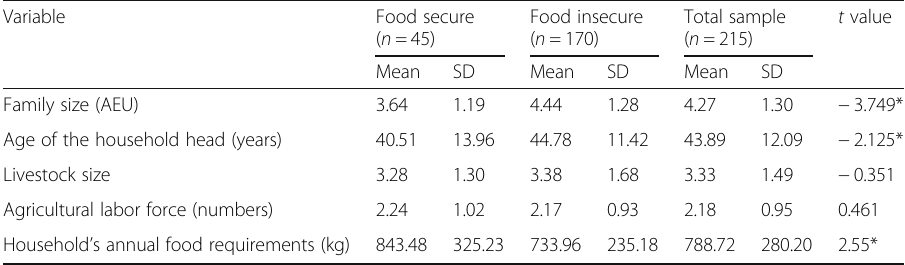
Table 2 Descriptive statistics of continuous variables